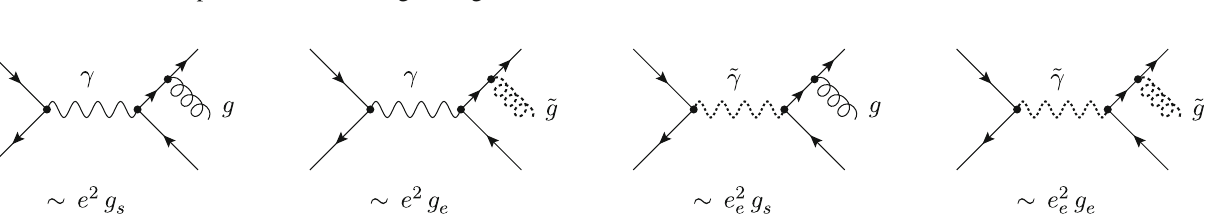
Fig. 5 Real diagrams for e + e − → q ¯ qg and e + e − → q ¯ q ˜ g . In cdr and hv there is only the first diagram, whereas in fdh also the second diagram is present. In dred , all diagrams contribute. An analogous diagram where the gluon couples to the other quark leg is